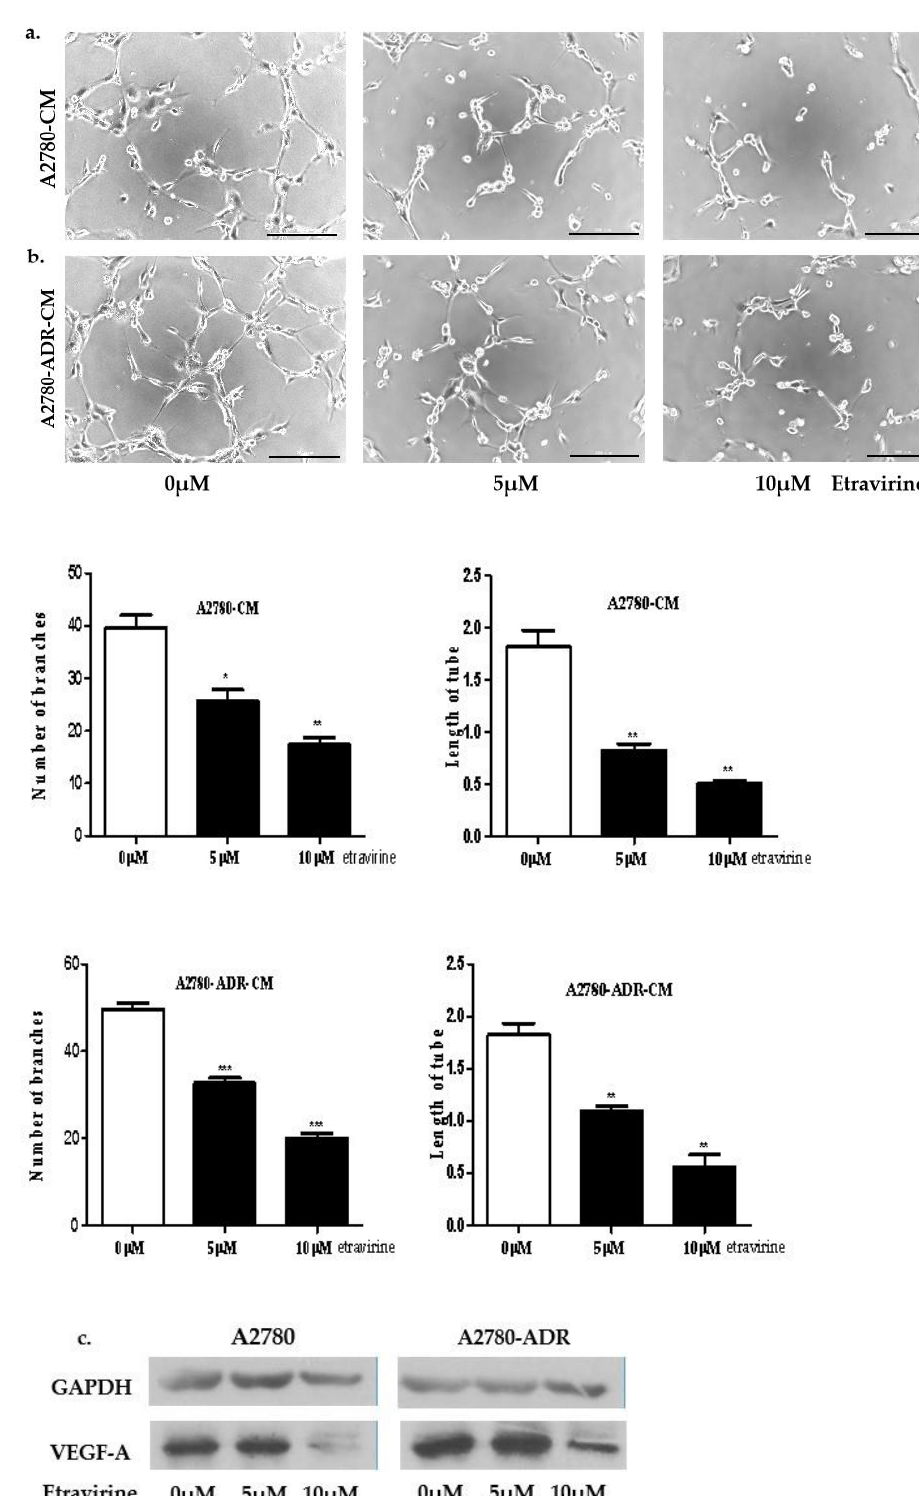
Figure 4. Etravirine inhibits HUVECs tube formation. ( a , b ) Representative images of tube formation. Etravirine with the indicated concentrations inhibit the tube formation abilities of A2780- and A2780-ADR-conditioned media. Quantitative analysis of the number of tubes and the total length of tubes. Scar bar = 200 µm. Data are shown as mean ± SEM.* p < 0.05, ** p < 0.01, *** p < 0.001. ( c ) Western blot analysis showing the expression of VEGF-A after treatment with etravirine (0, 5, and 10 µM) for 72 h.